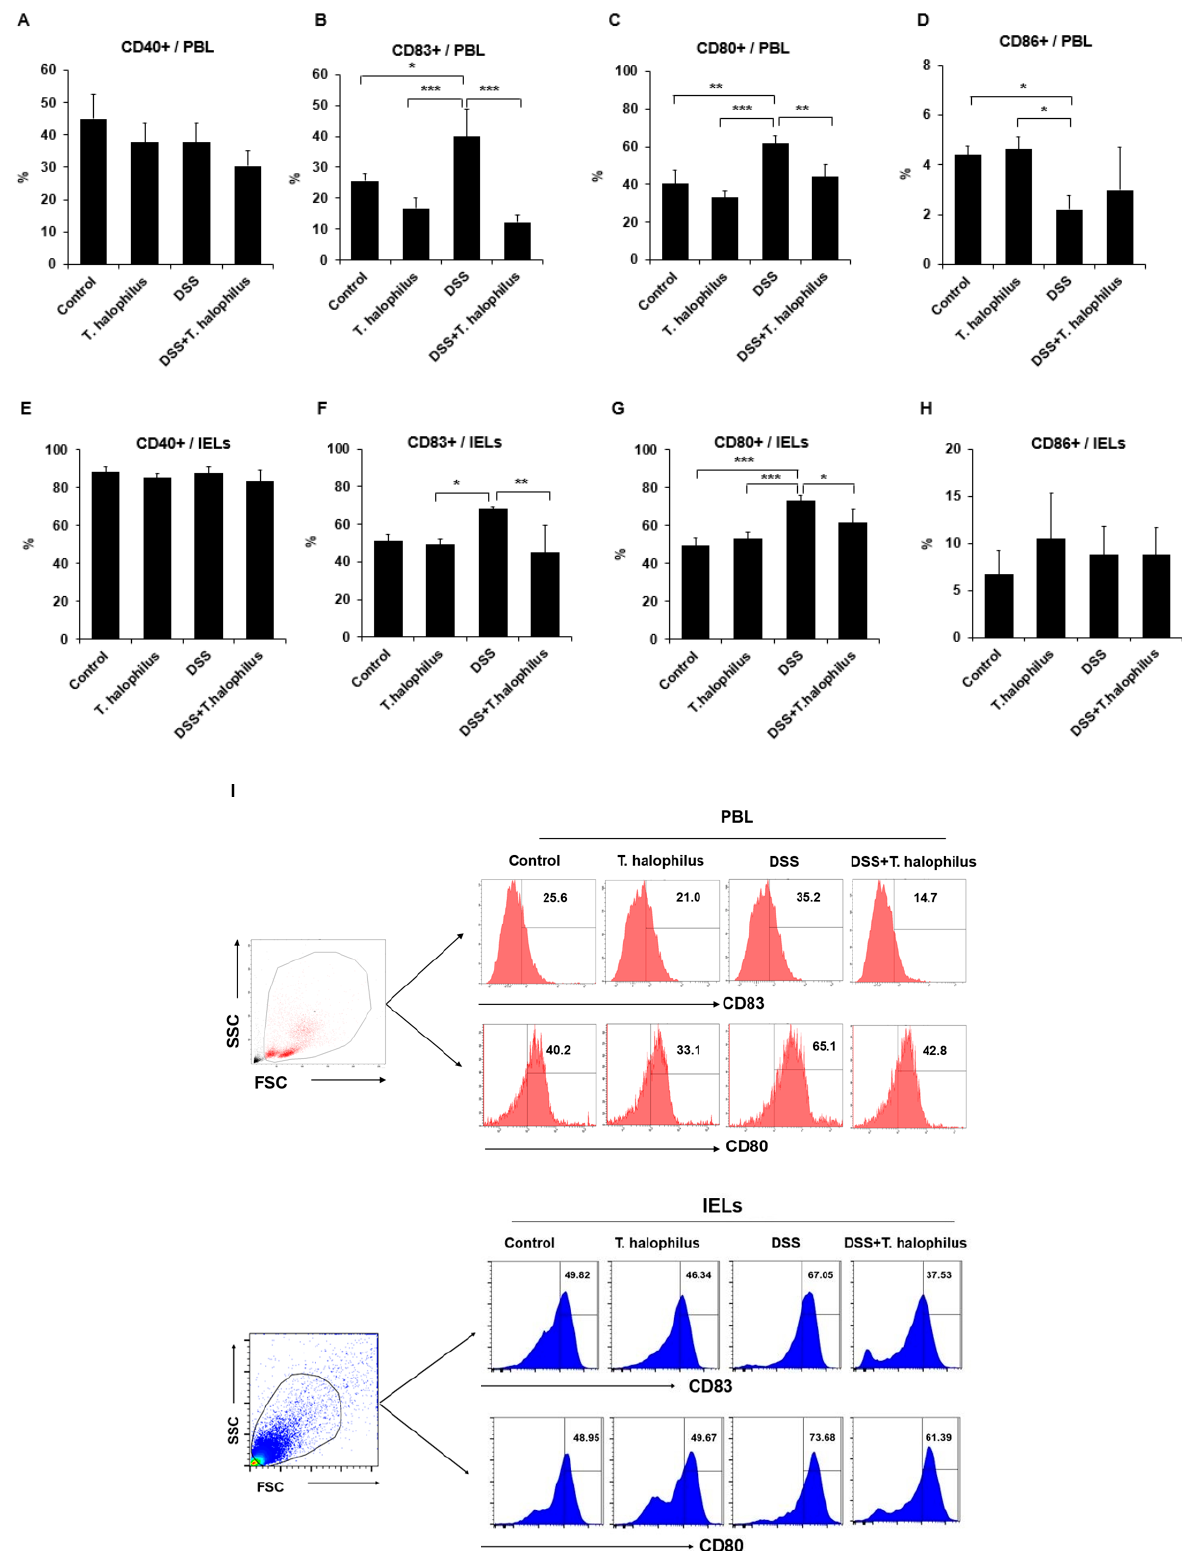
Figure 2. Frequencies of cells positive for DCs costimulatory molecules CD40, CD83, CD80, and CD86 in peripheral blood leukocytes (PBL) and intestinal epithelial lymphocytes (IELs) were